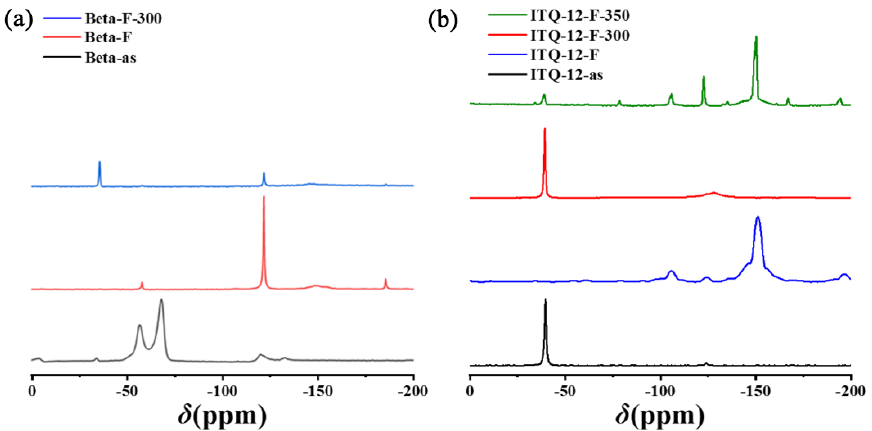
Figure 2 Figure 2. The 19 F-MAS-NMR of ( a ) Beta, Beta-F and Beta-F-300; ( b ) ITQ-12, ITQ-12-F-calcined, ITQ-12-F-300 and